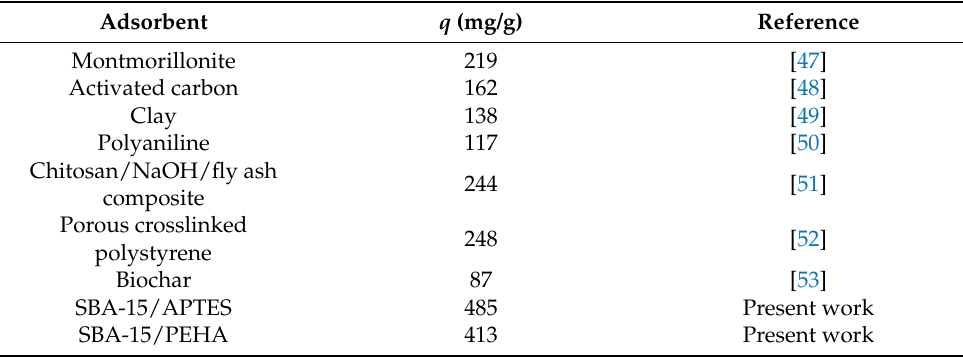
Table 5. Maximum adsorption capacity for TA adsorption onto various